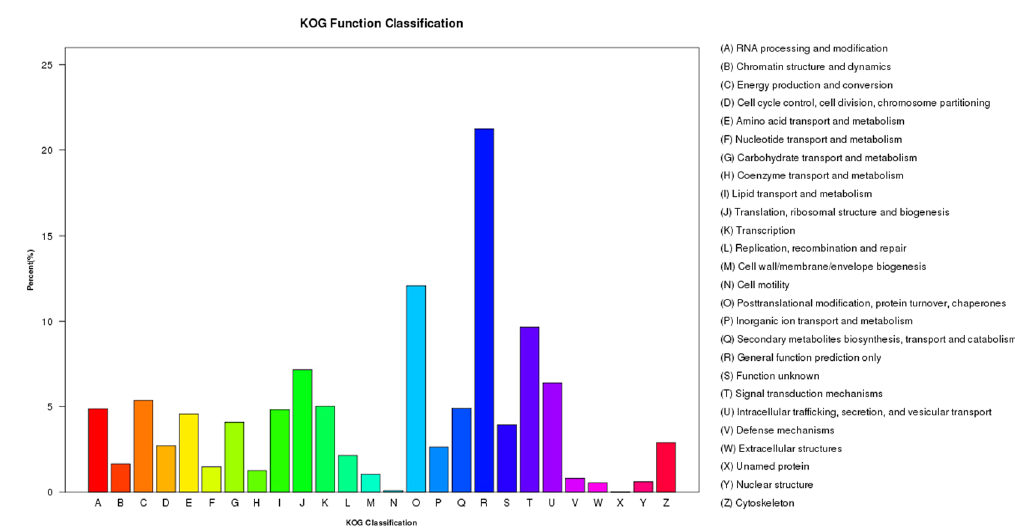
Figure 5. KOG annotation of putative